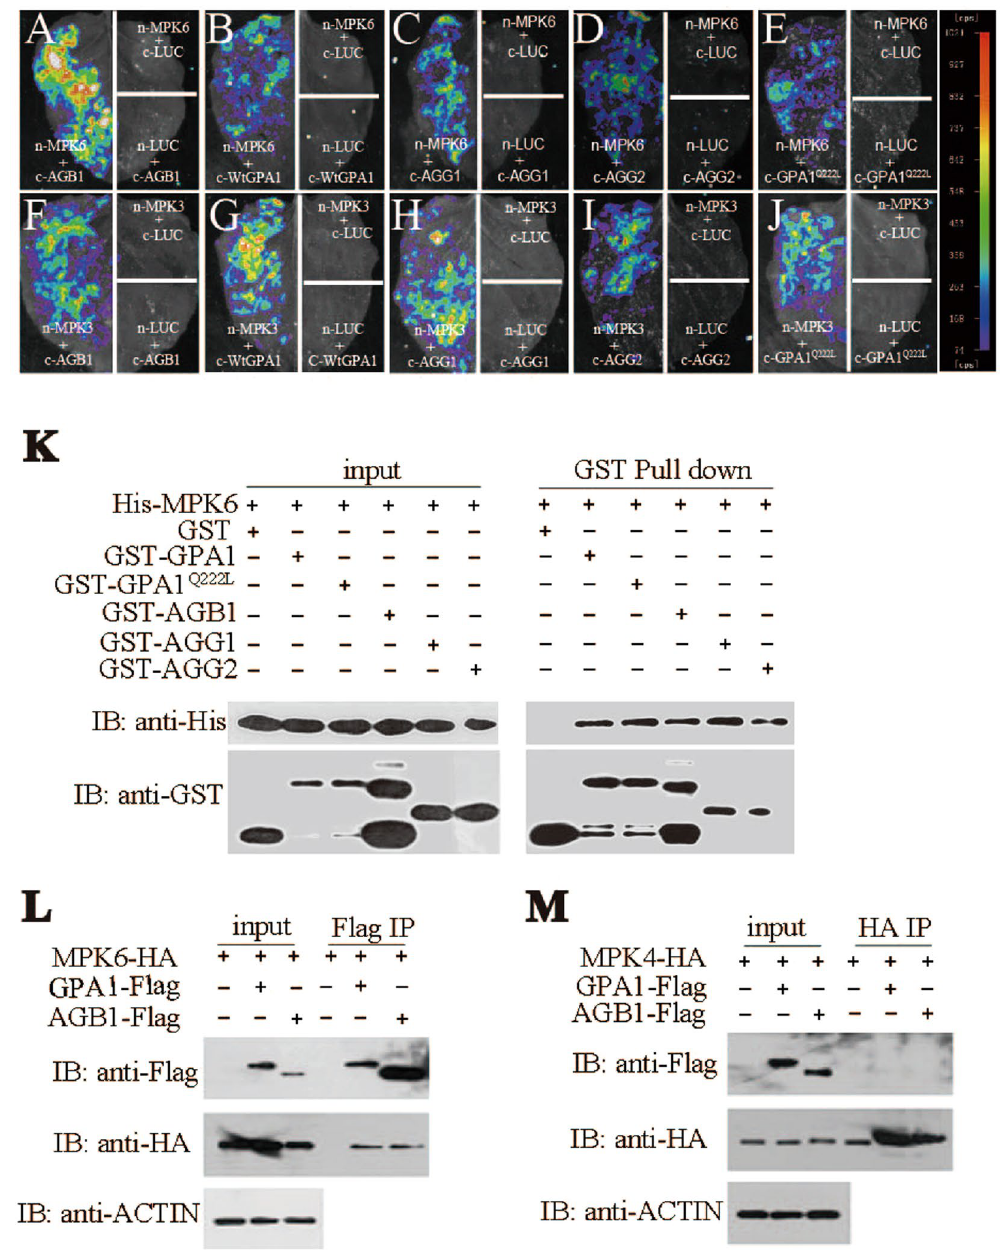
Figure 1. AGB1, GPA1, AGG1 and AGG2 interact with MPK6 and MPK3. ( A – J ) Tobacco leaves co-infiltrated with agrobacterium containing 35S -driven split luciferase (LUC) constructs as indicated were photographed with a charge-coupled device camera. Each image is representative of three images in three independent experiments. ( A – E ) MPK6-nLUC interacts with cLUC-AGB1 ( A ), cLUC-WtGPA1 ( B ), cLUC-AGG1( C ), cLUC-AGG2 ( D ), cLUC-GPA1 Q222L ( E ), respectively. ( F – J ) MPK3-nLUC interacts with cLUC-AGB1 ( F ), cLUC-WtGPA1 ( G ), cLUC-AGG1 ( H ), cLUC-AGG2 ( I ), cLUC-GPA1 Q222L ( J ), respectively. The pseudocolor bar shows the relative range of luminescence intensity in images. Pull-down assay shows that AGB1, WtGPA1, GPA1 Q222L , AGG1 and AGG2 interact with MPK6 ( K ), respectively. AGB1 and GPA1 interact with MPK6 ( L ), but not MPK4 ( M ) by Co-IP assay. Full blots are shown in Supplemental